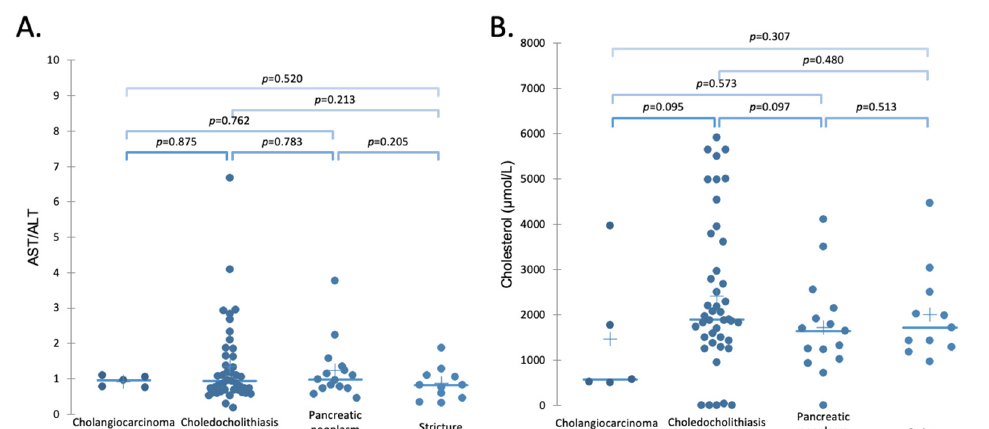
Figure 2. AST/ALT ratio ( A ) and cholesterol levels ( B ) measured in bile collected from patients with different malignancies. ( A ). Traditional liver diagnostic tests. AST/ALT ratio were not able to successfully differentiate the biliary blockages. ( B ). Cholesterol levels of the bile were not significantly different in any of the disease groups; however, the highest cholesterol levels were found for the choledocholithiasis patients.